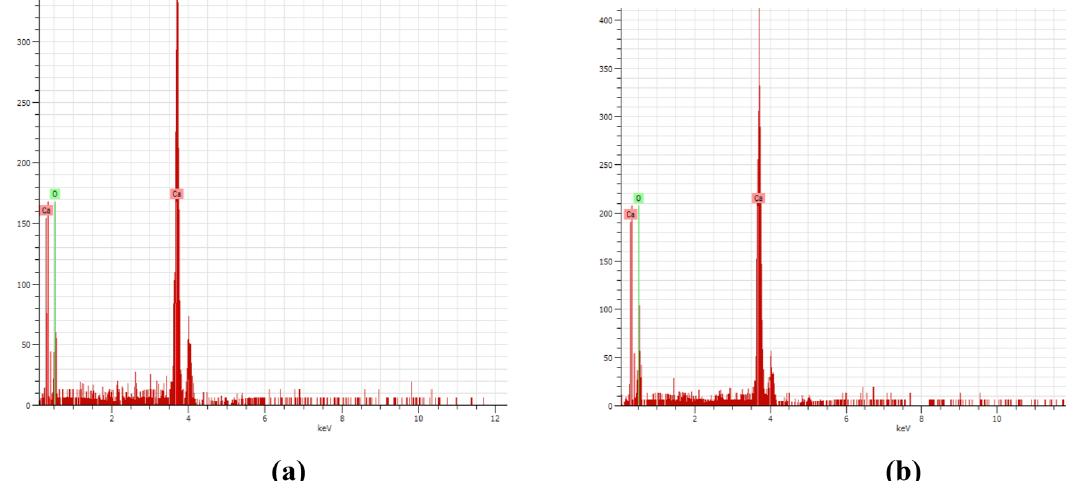
Fig. 4 EDX images of a CaO-M and b CaO-F